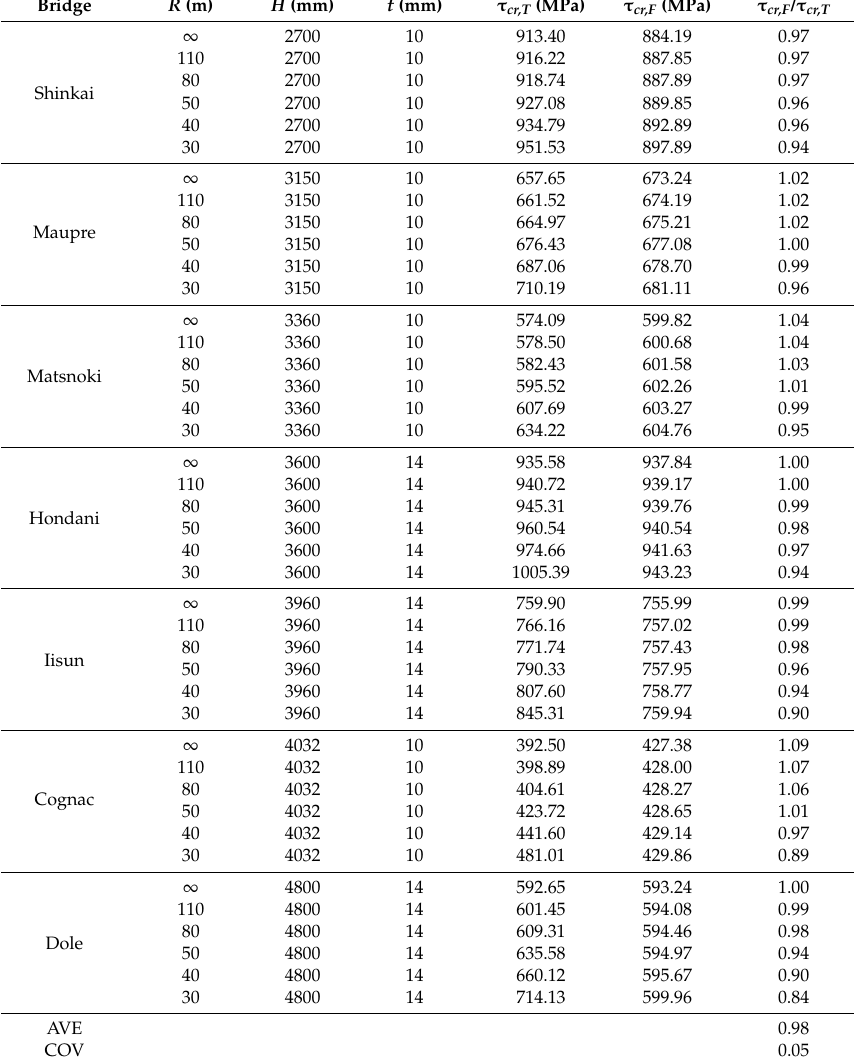
Figure 15. Different angles θ 1 , θ and θ 2 versus curvature radius R.